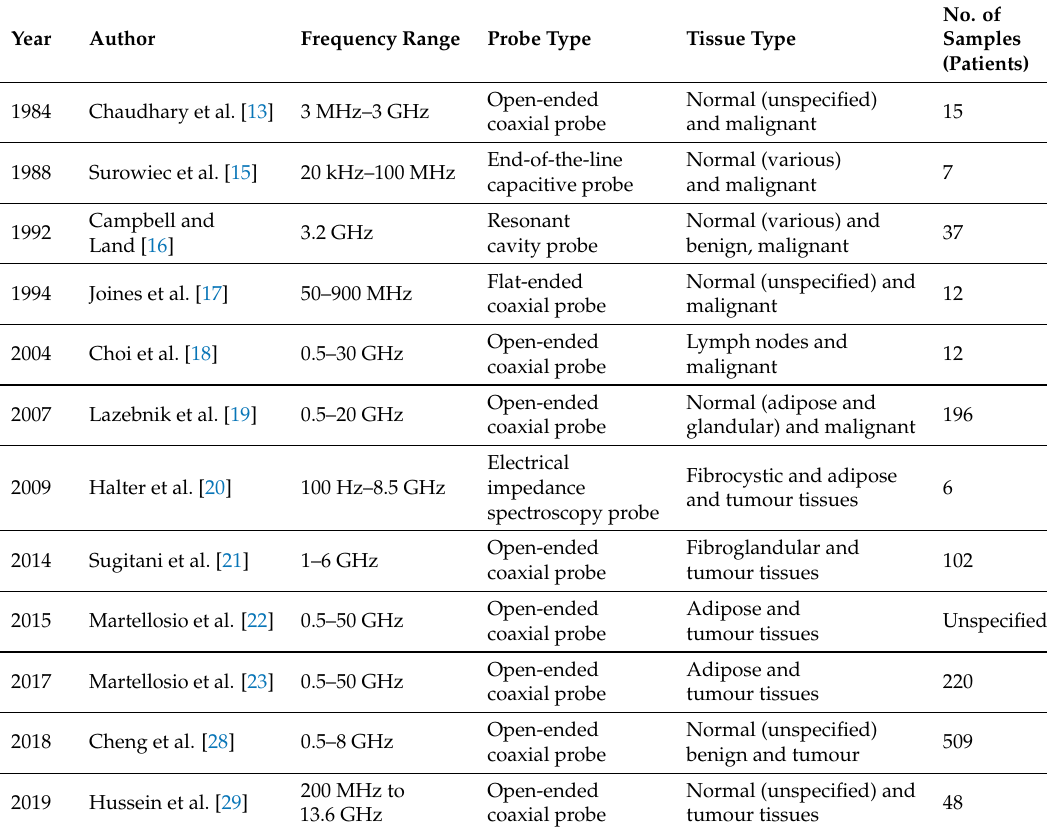
Table 2. Chronological summary of several studies of the dielectric properties of human female breast